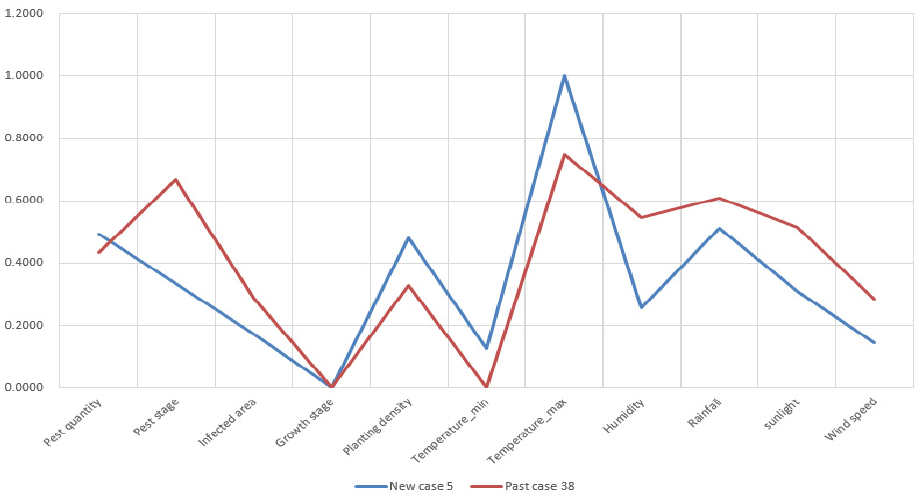
Figure A5. Attribute visualization of new case 5 and retrieved past case 38.